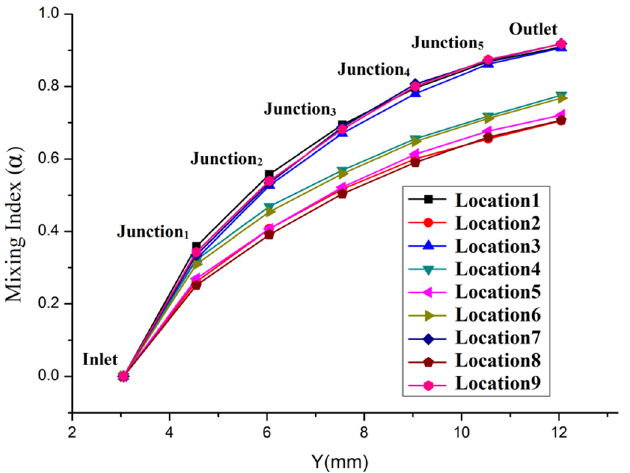
Figure 5. The mixing indexes of the repetitive structure micromixers with different junction locations.